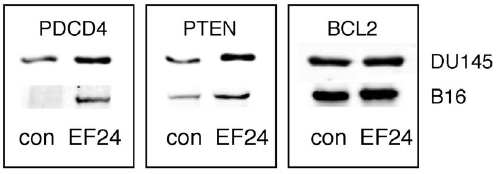
Figure 5. The effects of EF24 miR-21 target protein expression in DU145 and B16 cells invitro . DU145 and B16 cells were treated with 5 m M EF24. At 24 hr after EF24 treatment cells were lysed, and the expression of miR-21 target proteins was determined by immunoblot- ting.